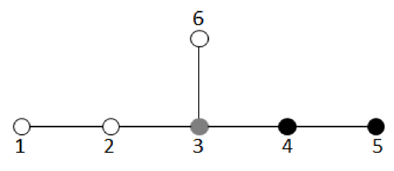
Figure 2 . The Dynkin diagram of E 6 . The Dynkin node labelled i corresponds to the exceptional divisor D . The solid nodes are the ones we break to get the Standard Model gauge group and chiral i matter. Node 3 (gray) is broken by remainder flux while the others are broken by vertical flux.